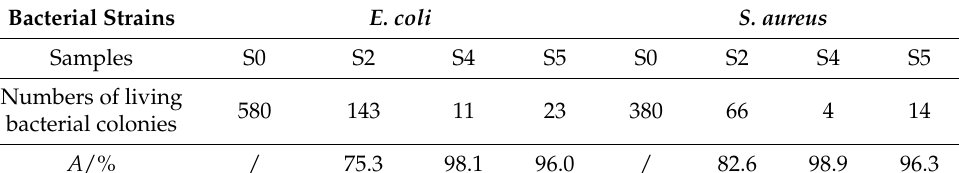
Table 1. Antibacterial activities of CuO-zeolite NCs.